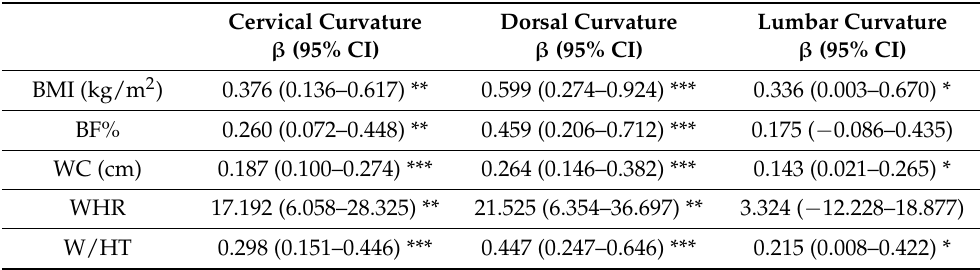
Table 2. Linear regression models for the evaluation of the effect of body composition variables on the degrees of the cervical, dorsal, and lumbar vertebral angles.